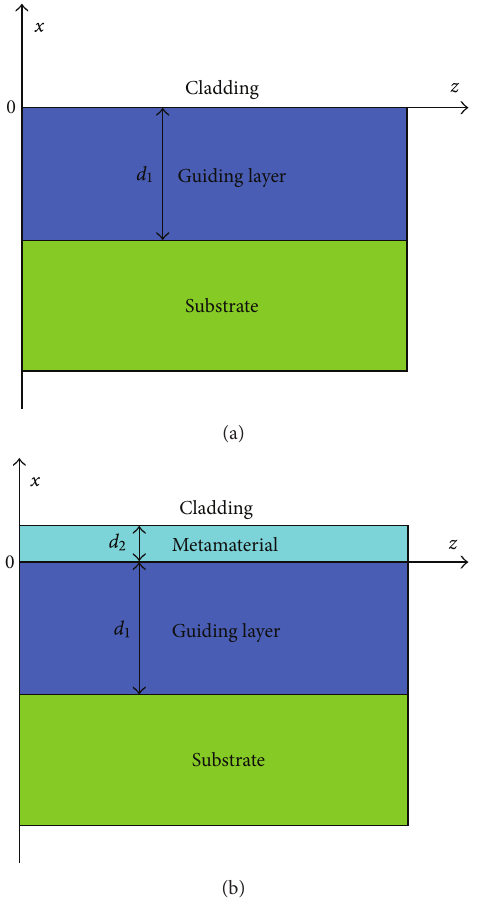
Figure 1: Simulation model of the traditional planar waveguide sen- sor (a) and the planar waveguide sensor covered with a layer of met- amaterials